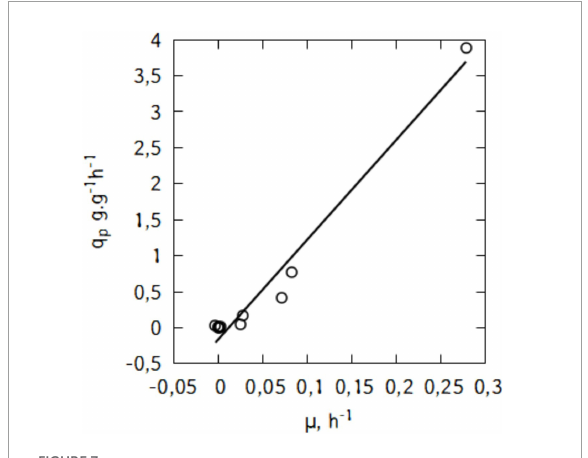
FIGURE7 Relationship between specific lactic acid formation rate ( q p ) and specific growth rate ( µ ) during shake-flask cultivation of L. casei in traditional cheese